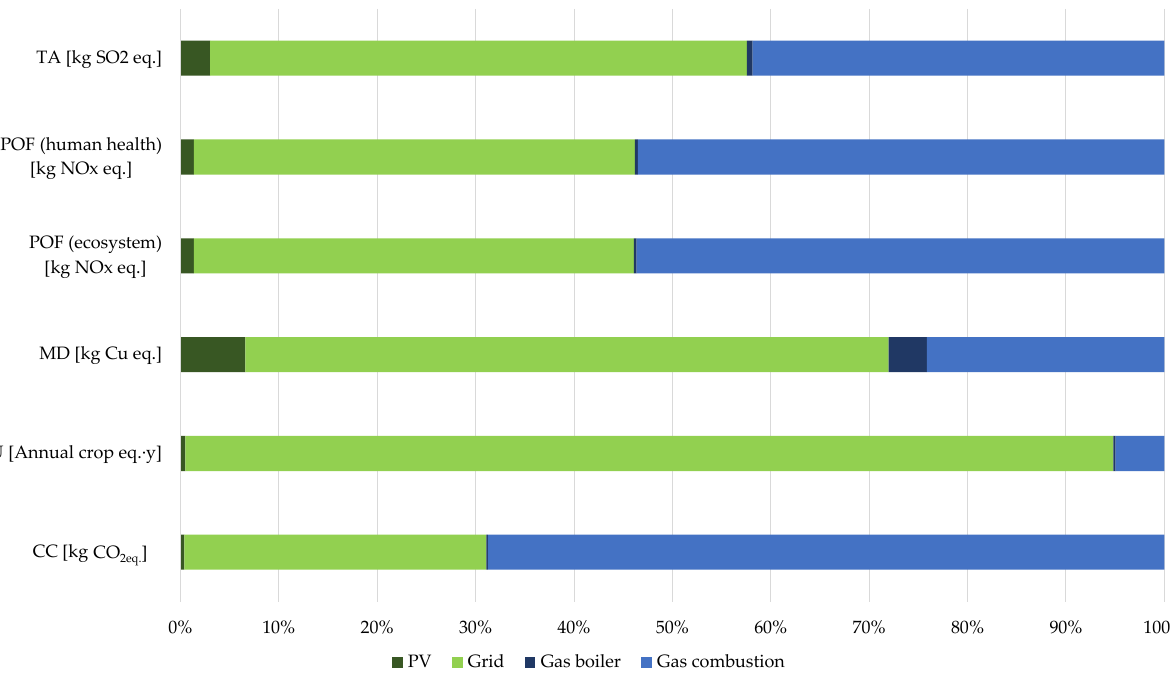
Figure 5. Results of base case, percentage distribution, midpoint level. Abbreviations: CC = climate change, LU = land use, POF = photochemical ozone formation, TA = terrestrial acidification, MD = metal depletion.